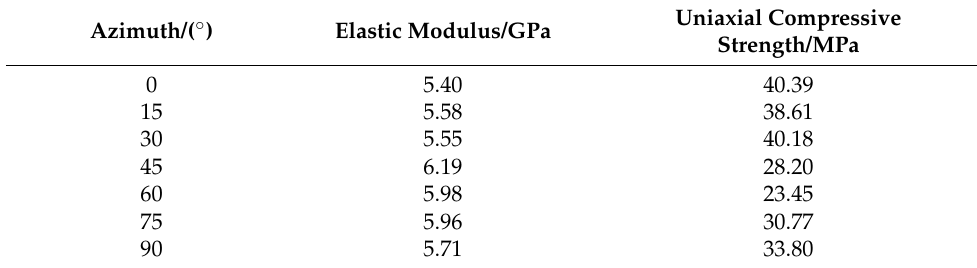
Table 2. Modulus of elasticity and uniaxial compressive strength of coal rock.